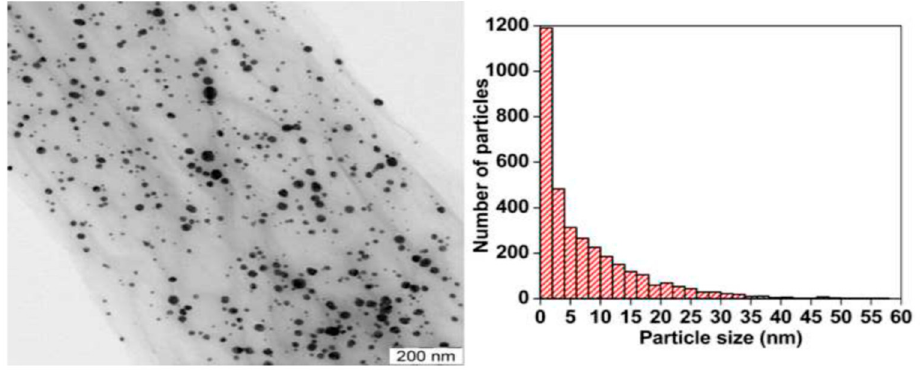
Figure 3. Transmission electron micrograph of GO-AgNPs (left panel) and the size distribution of AgNPs (right panel). The average size of AgNPs is 7.5 nm. Reproduced with permission from [72]. Copyright Elsevier, 2014.